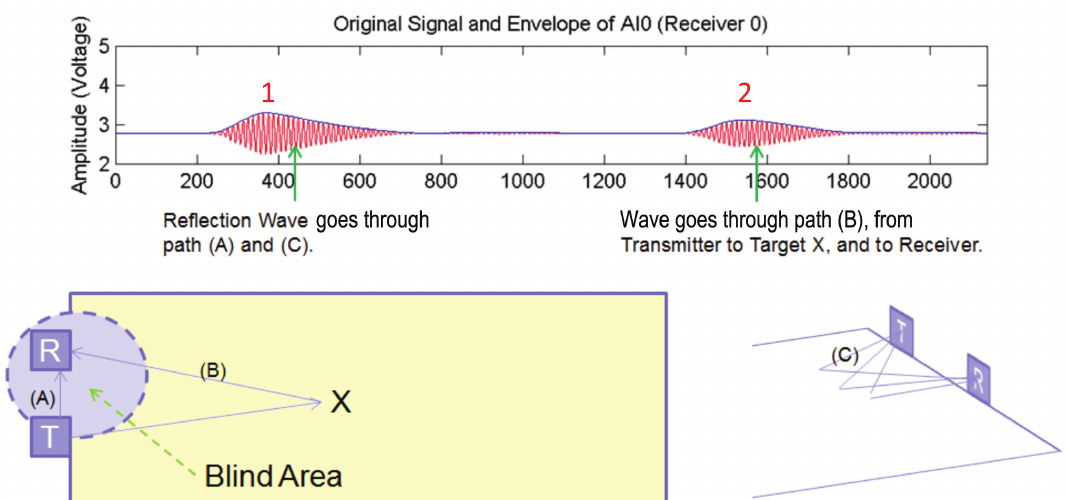
Figure 3. Illustration of blind area. ( Top ): Interference signal 1 and reflected signal 2; ( Bottom-left ): Paths of interference signal (A) and reflected signal (B); ( Bottom-right ): Path of interference signal